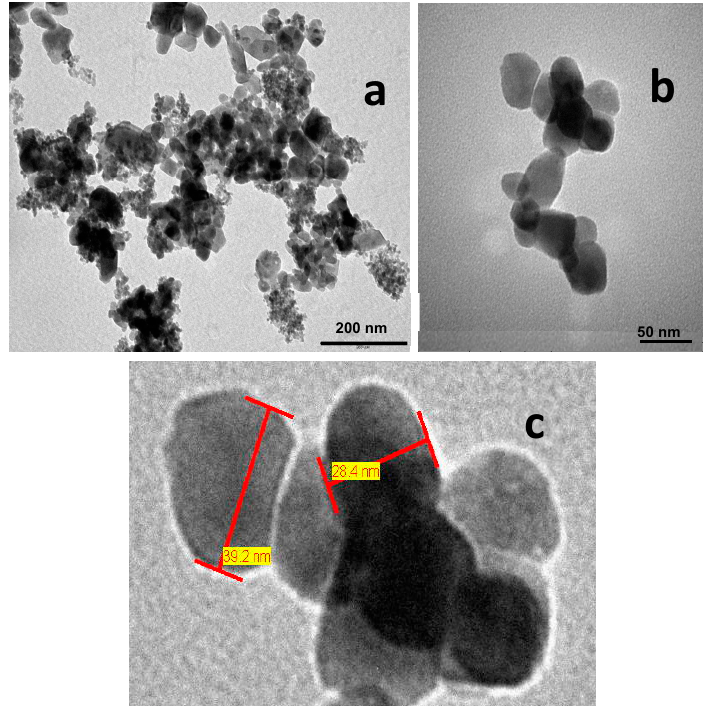
Figure 5. The TEM micrographs of the as-prepared β -CoMoO 4 powder ( a ) at low magnification ( × 100,000), scale bar 200 nm; and ( b ) at high magnification ( × 500,000), scale bar 50 nm; ( c ) Measured particle size at high magnification.